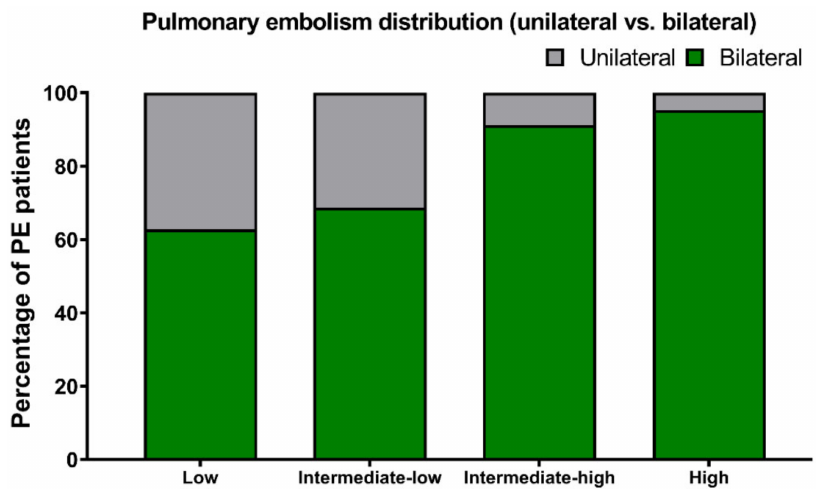
Figure 4. Pulmonary embolism distribution (unilateral vs. bilateral) according to the risk of early mortality.